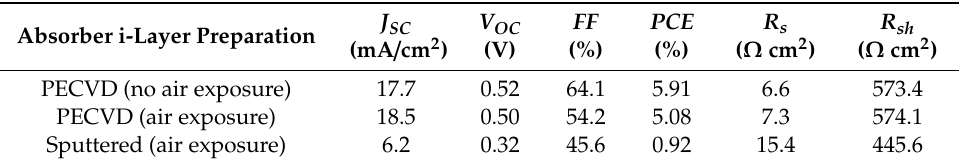
Table 2. Comparison of device performance parameters of highest efficiency n-i-p cells incorporating nc-Si:H absorbers prepared with each absorber layer processing method.